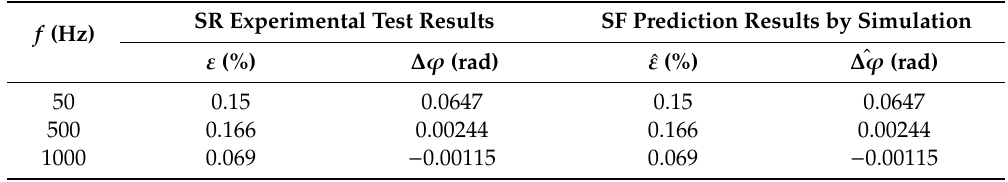
Table 5. SF Prediction results and comparison with SR experimental test results.